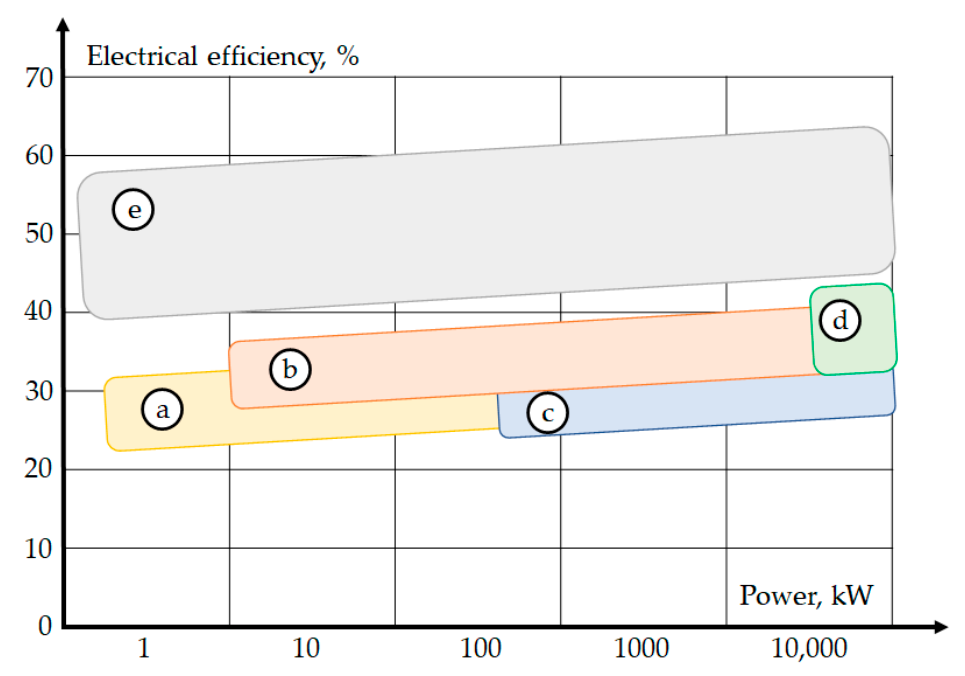
Figure 2. Electrical efficiency of power plants of various types: ( a ) based on petrol generator units; ( b ) based on diesel generator units; ( c ) based on steam turbines; ( d ) based on gas-turbine units; ( e ) based on fuel cells.